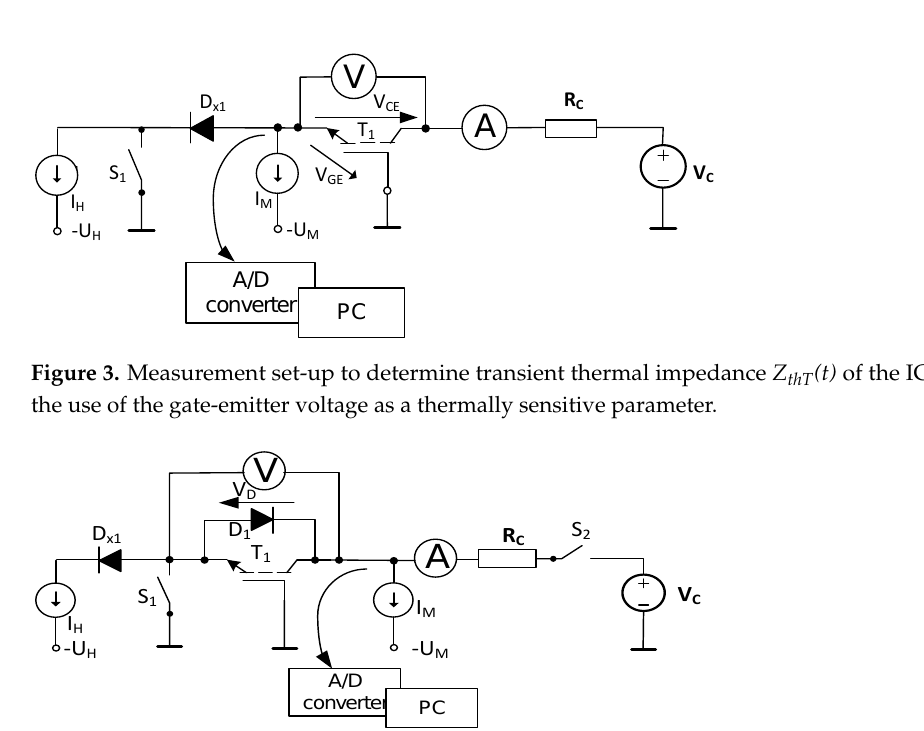
Figure 4. Measurement set-up to determine transfer transient thermal impedance Z thTD (t) of the IGBT with the use of forward voltage of the anti-parallel diode as a thermally sensitive parameter.